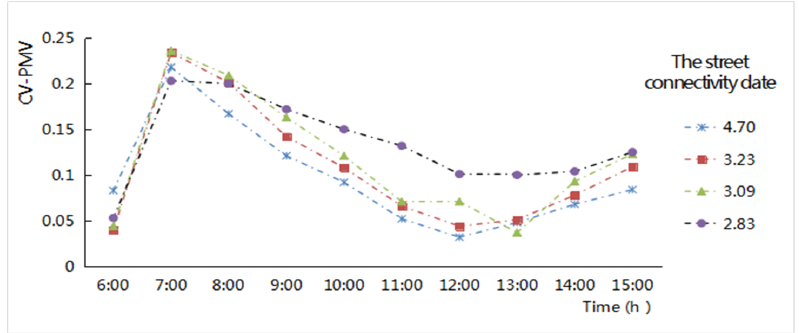
Figure 13. Hourly CV values variation of the PMV value related to different street connectivity of the street network from 6:00 to 15:00 in the four study areas.